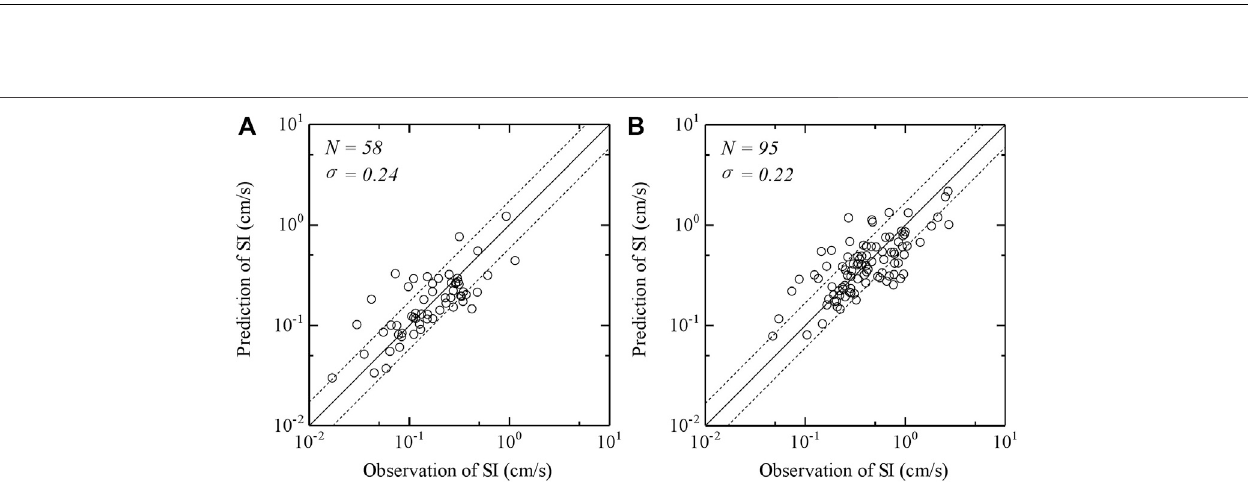
Frontiers in Earth Science |